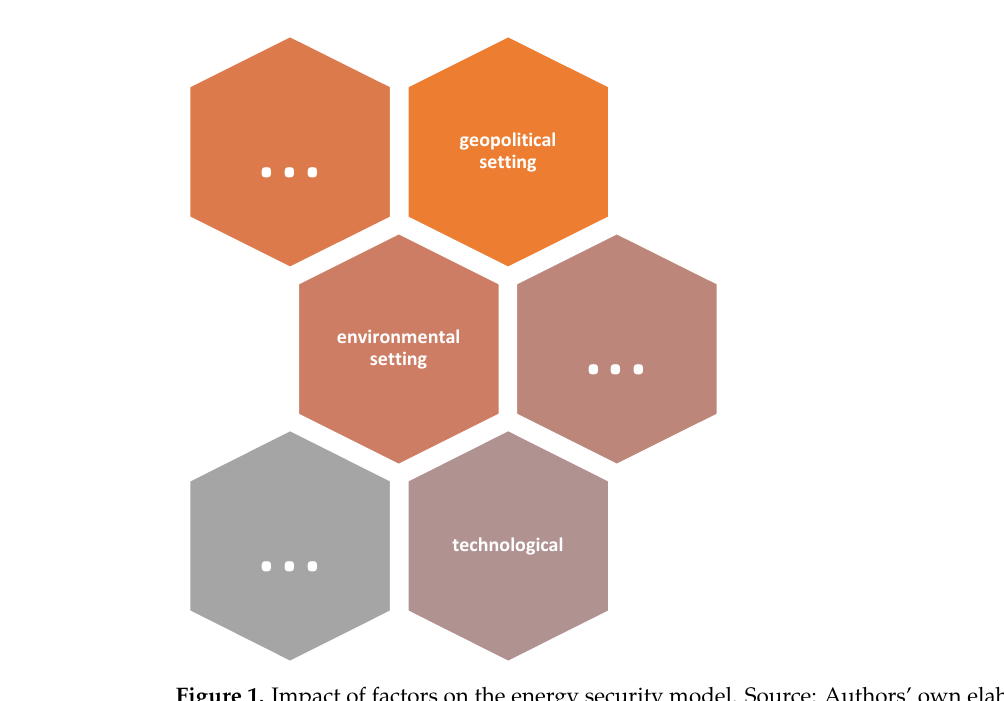
Figure 1. Impact of factors on the energy security model. Source: Authors’ own elaboration.